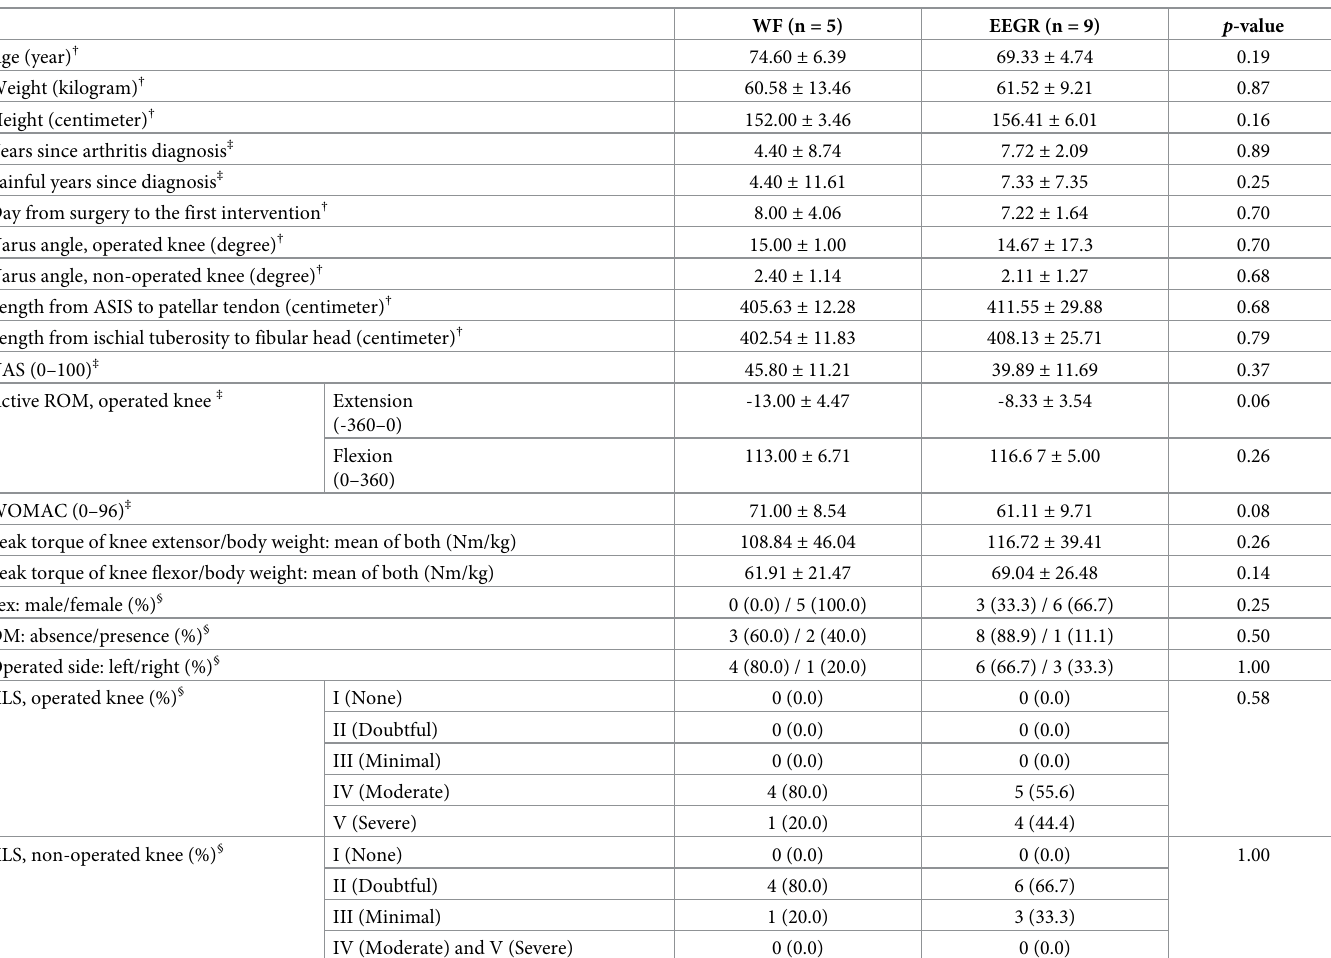
Table 1. Demographic characteristics of patient